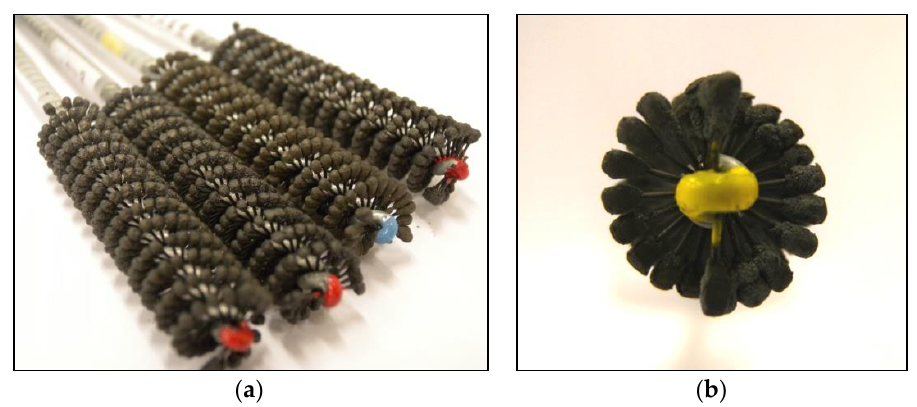
Figure 1. ( a ) Tools with different abrasive qualities. ( b ) Tool detail (3×).